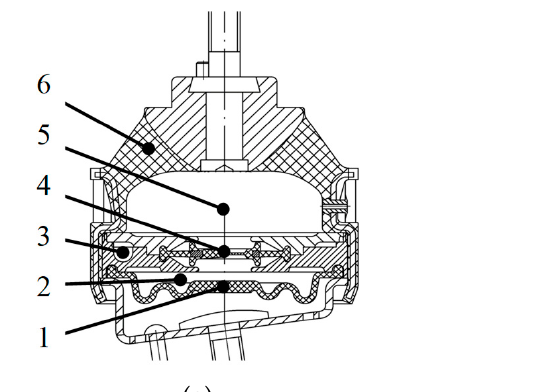
Figure 1. Configuration schematics for PHM-IT-DM and AHM-IT-DM-OCA. ( a ) PHM-IT-DM; ( b ) AHM-IT-DM-OCA. Key : 1. rubber bellow; 2. lower chamber; 3. inertia track; 4. decoupler membrane; 5. upper chamber; 6. main rubber spring; 7. decoupler/actuator mover; 8. coil; 9. permanent magnet.